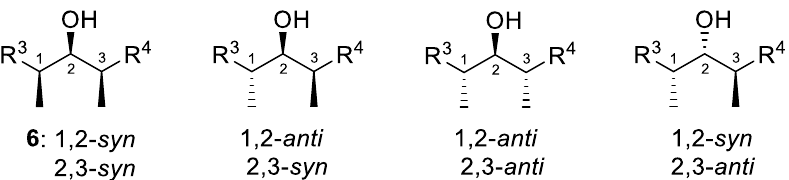
Figure 2. Four possible diastereomeric polypropionate stereotriads of type R 3 -CH(Me)-CH(OH)- CH(Me)-R 4 . Their enantiomers are not shown. Other stereotriads could be of the type R 3 -CH(OH)- CH(Me)-CH(OH)-R 4 .